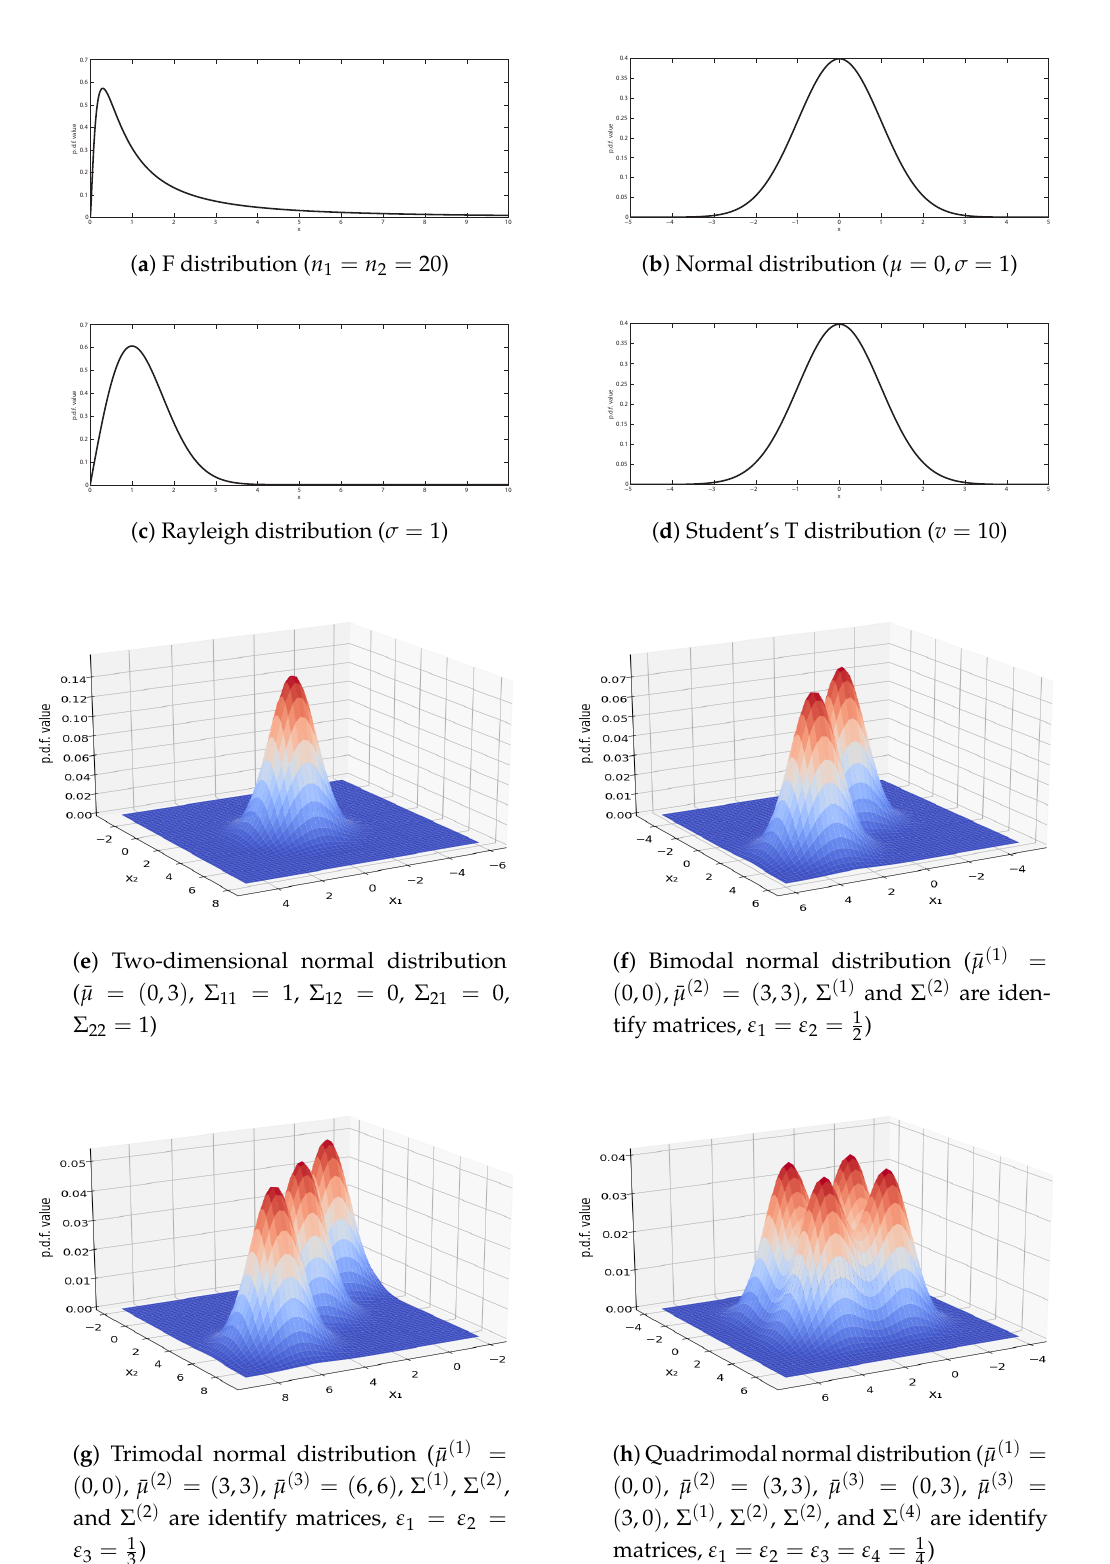
Figure 1. Graphics of eight p.d.f.